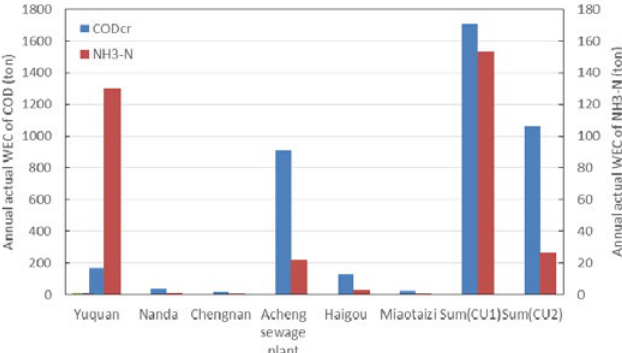
Table 6: Surplus water environmental capacity of COD Cr at each outlet and control unit (ton) Control unit 1 Control unit 2 Month Acheng Yuquan Nanda Chengnan Sum Haigou Miaotaizi Sum sewage plant Jan. 46.39 ‐ 32.15 ‐ 7.01 7.23 ‐ 10.80 1.66 ‐ 23.80 ‐ 32.94 Feb. 36.12 ‐ 31.74 ‐ 6.79 ‐ 2.41 ‐ 17.13 2.85 ‐ 23.53 ‐ 37.81 Mar. 49.46 ‐ 32.18 ‐ 7.03 10.25 13.44 1.55 ‐ 23.82 ‐ 8.83 Apr. 57.69 ‐ 32.61 ‐ 7.27 17.81 14.30 0.31 ‐ 24.10 ‐ 9.49 May. 56.14 ‐ 33.13 ‐ 7.57 15.44 17.45 ‐ 1.20 ‐ 24.45 ‐ 8.20 Jun. 232.24 ‐ 29.90 ‐ 5.74 196.60 39.12 ‐ 22.31 24.85 Jul. 220.41 ‐ 29.28 ‐ 5.39 185.74 20.53 9.81 ‐ 21.90 8.44 Aug. 225.43 ‐ 31.50 ‐ 6.64 187.29 61.20 3.46 ‐ 23.36 41.30 Sep. 143.09 ‐ 33.00 16.54 126.44 ‐ 30.73 ‐ 6.21 89.50 54.39 5.71 ‐ 22.86 37.24 Nov. 59.13 ‐ 32.81 ‐ 7.38 18.94 10.94 ‐ 0.27 ‐ 24.23 36.95 ‐ 31.99 ‐ 6.93 ‐ 1.97 ‐ 24.07 2.11 ‐ 23.70 ‐ 45.66 1289.49